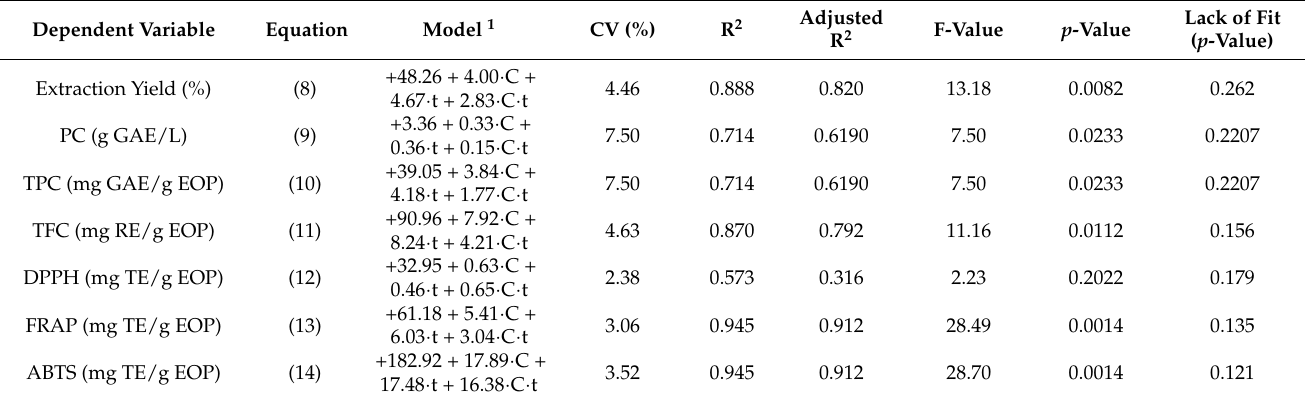
Table 7. Mathematical models and coefficients of the studied responses using coded values for the factorial design applied to the probe-type ultrasound-assisted extraction of exhausted olive pomace